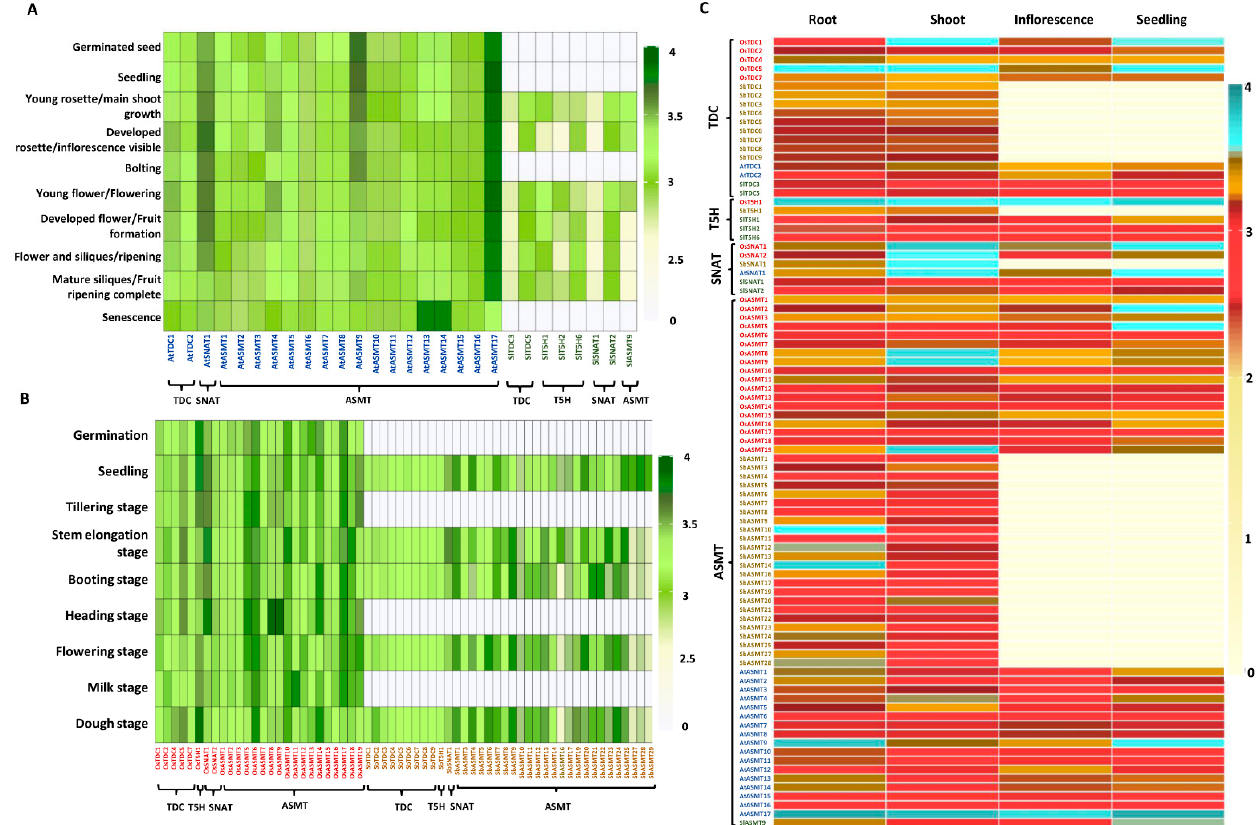
Figure 4. Tissue-specific and developmental regulation of genes encoding Ser and Mel biosynthetic enzymes in different plant species. Expression profile of genes encoding Ser and Mel biosynthetic enzymes in dicots ( A ), Arabidopsis and tomato, and monocots ( B ), rice and sorghum, was obtained from the publicly available Genevestigator database. Data was retrieved for different developmental stages ( A , B ) and different tissues ( C ), namely root, shoot, inflorescence and seedling. Colour scale on the right side of the heatmaps indicates the levels of expression. Grey/Light yellow colour indicates unavailability of data. Data pertaining to the T5H gene family of Arabidopsis was not available and, hence, is not shown. TDC , Tryptophan decarboxylase; T5H , Tryptamine-5-hydroxylase; SNAT , Serotonin-N-Acetyl transferase; ASMT , Acetylserotonin methyltransferase.